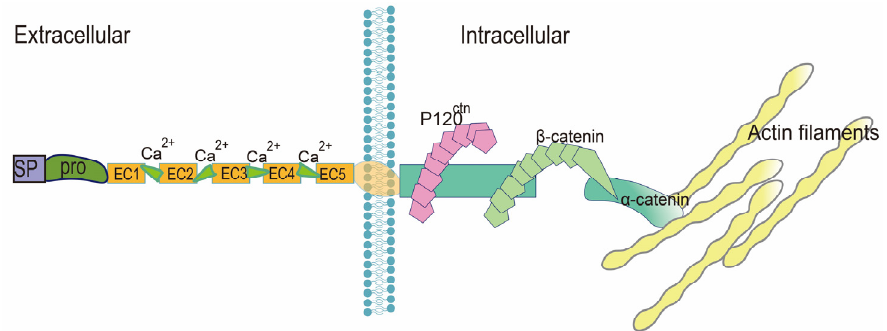
Figure 2. General structure of cadherins. Cadherins are single-pass transmembrane proteins in- cluding the extracellular domain and cytoplasmic domain. The extracellular domain consists of five homologous repeats (EC1-EC5) (linked by Ca 2+ ), SP, and pro. The cytoplasmic domain connects P120 ctn and β -catenin, while α -catenin binds to β -catenin to link the cadherin complex and the actin cytoskeleton.